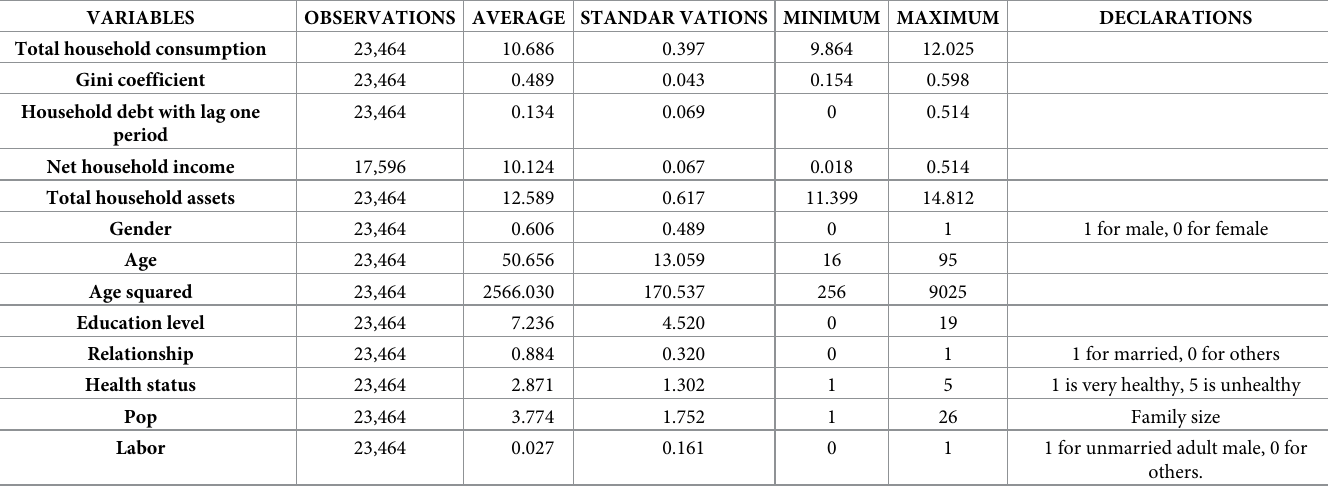
Table 1. Descriptive statistics of the variables.